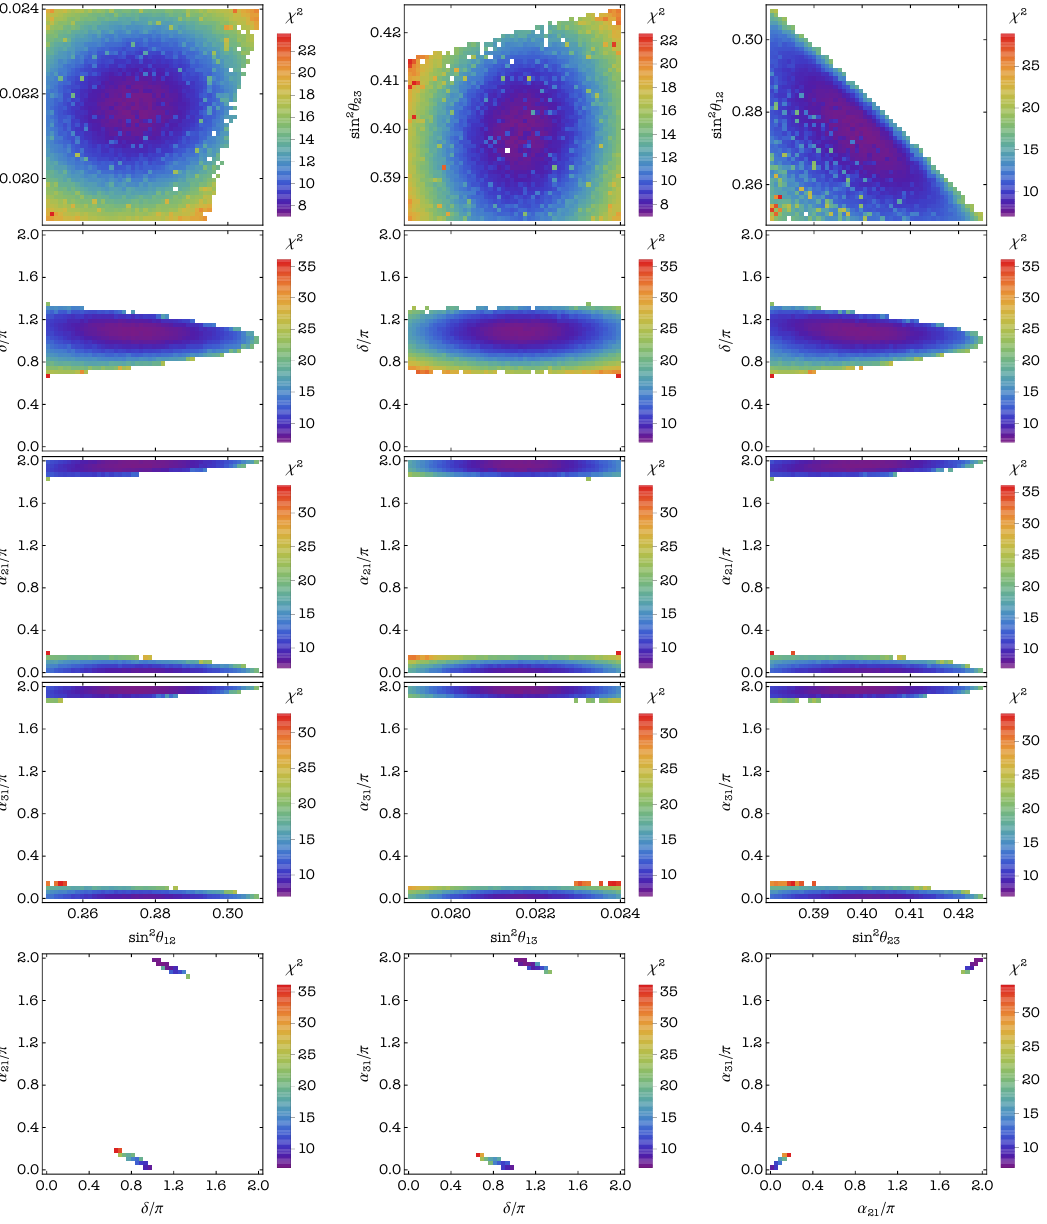
Figure 1 . Correlations between the neutrino mixing parameters in case B1. The values of all the three mixing angles are required to lie in their respective 3 (cid:27) ranges. Colour represents values of (cid:31) 2 for the NO neutrino mass spectrum.